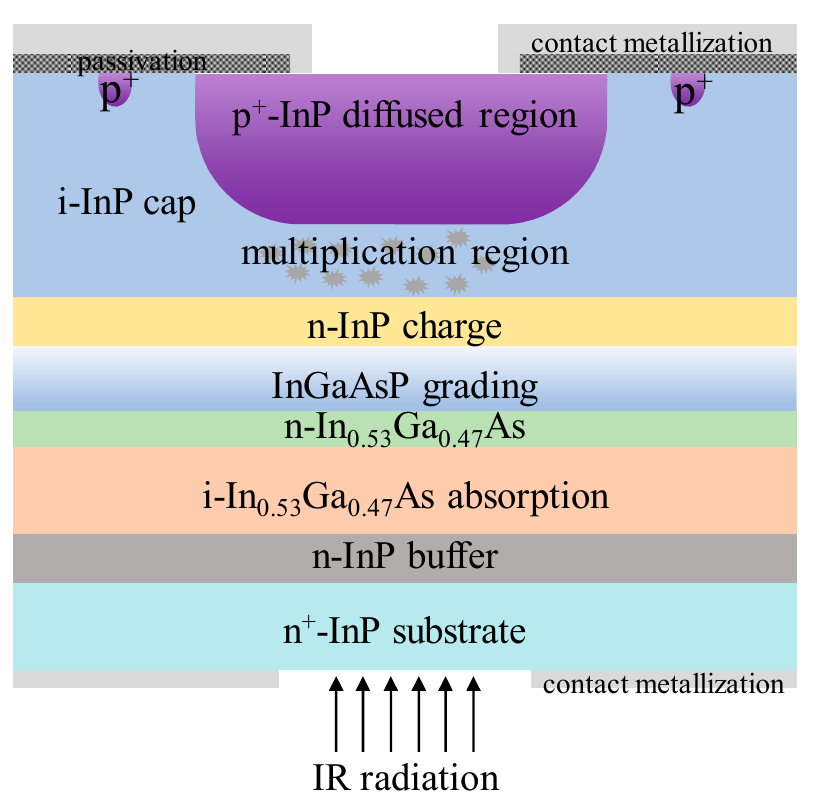
Figure 41. Schematic diagram and SEM image for the optimized back-illuminated planar InGaAs/InP APD